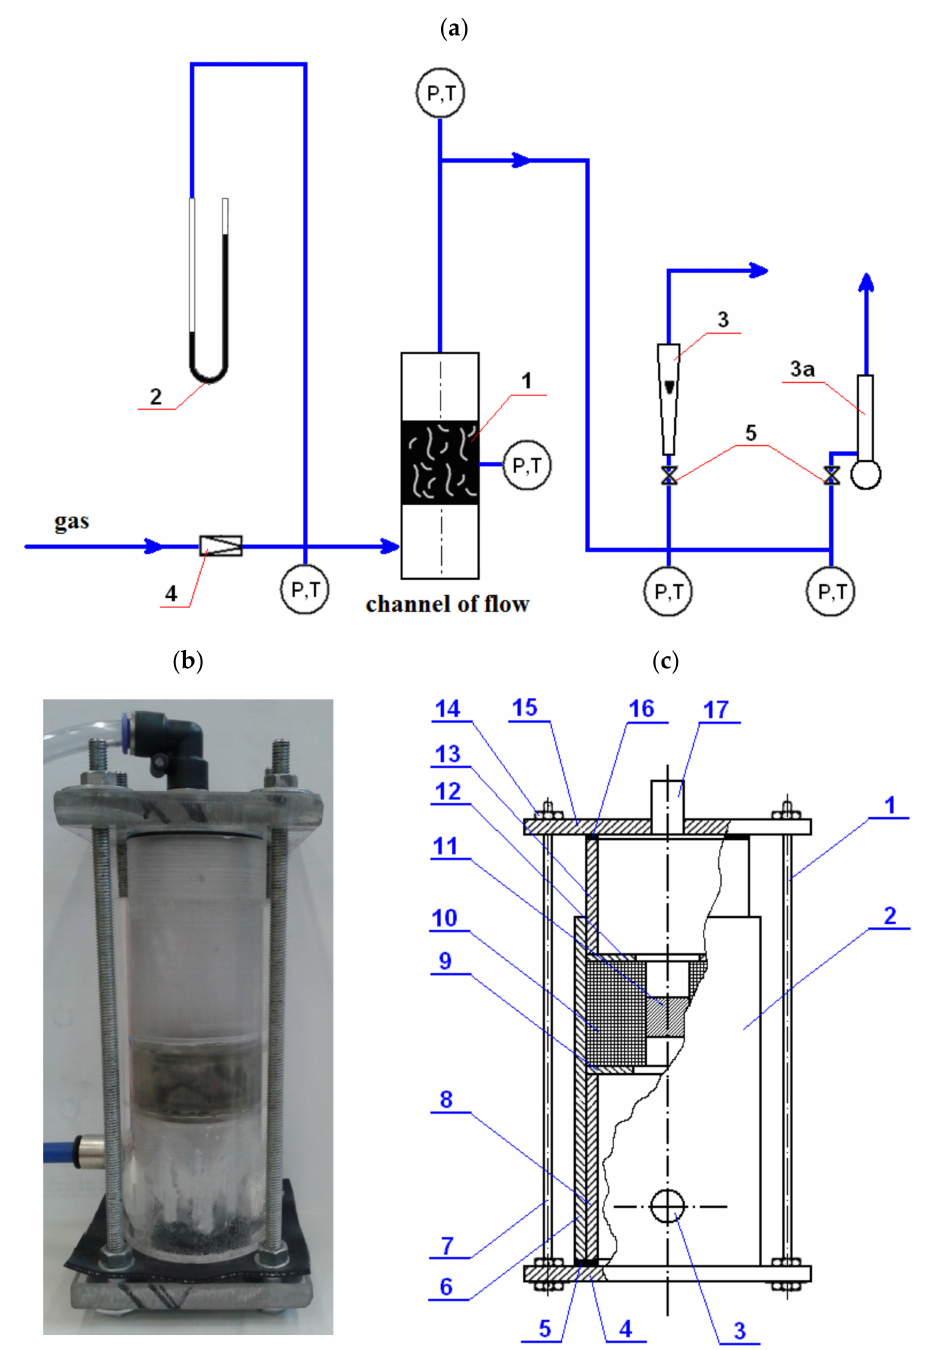
Figure 1. Measurement system for testing the permeability of porous materials for directed gas flow. ( a ) Diagram: 1—porous material (sample), 2—differential pressure manometer, 3—rotameter (3a—bubble flowmeter), 4—pressure reducers and 5—control valve; P = manometer and T = ther- mometer. ( b ) Gas permeability meter view. ( c ) Construction diagram: 1—casing, 2—cylindrical body, 3—gas inlet pipe, 4—bottom base, 5—bottom seal, 6—bottom fixed outer part, 7—threaded rod, 8—bottom fixed inner part, 9—lower thrust ring, 10—measuring cell, 11—porous material sample, 12—upper thrust sample, 13—upper movable sleeve, 14—nut, 15—upper base, 16—upper gasket and 17—gas outlet